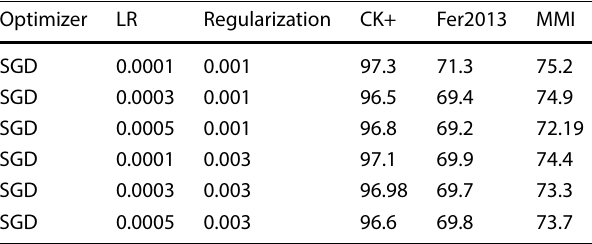
Table 3 Resnet hyperparameter